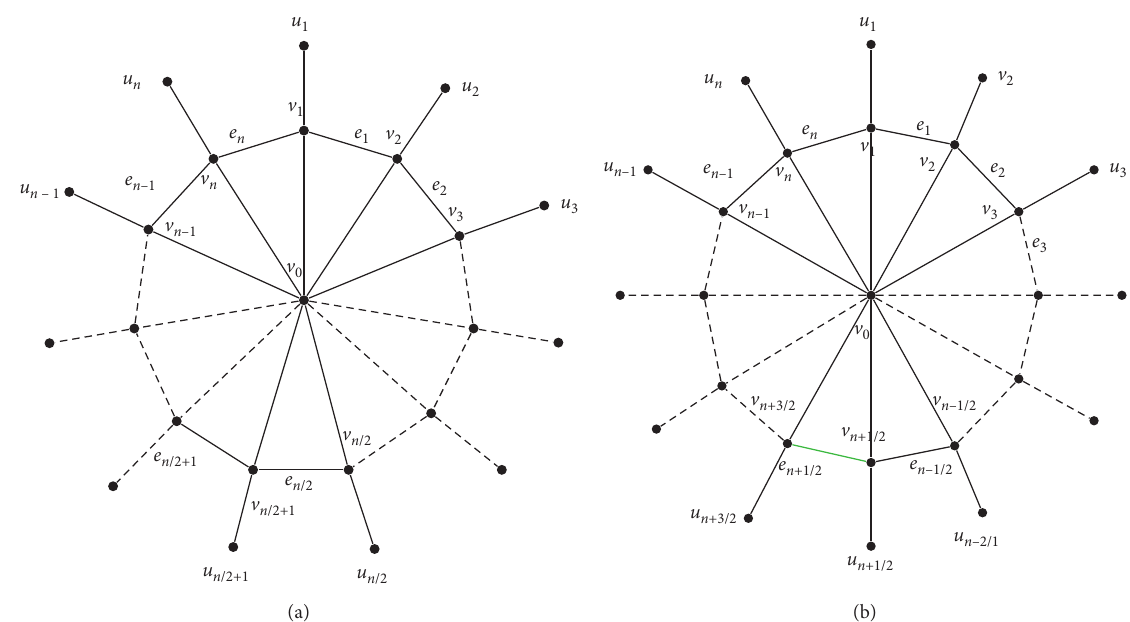
Figure 22: (a) The graph H